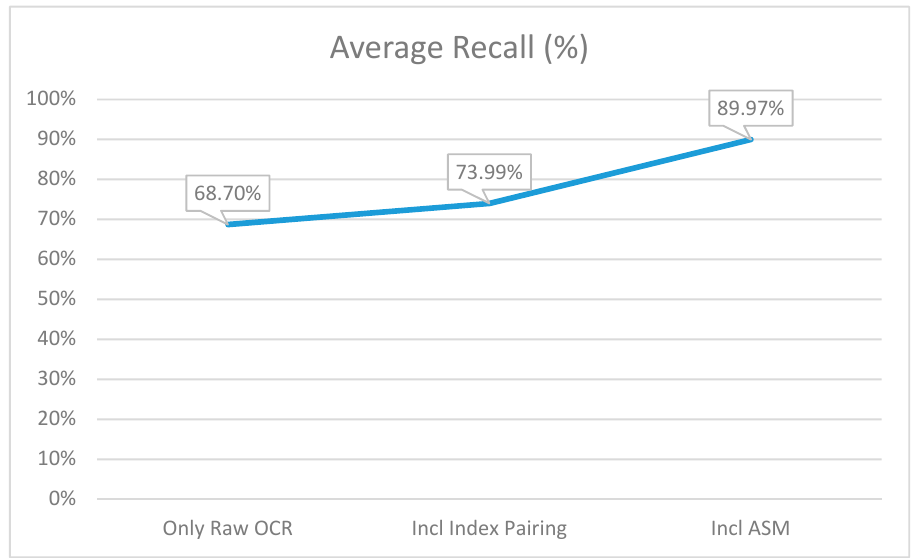
Figure 7. The average precision percentage at each of the three points of capturing the metrics.